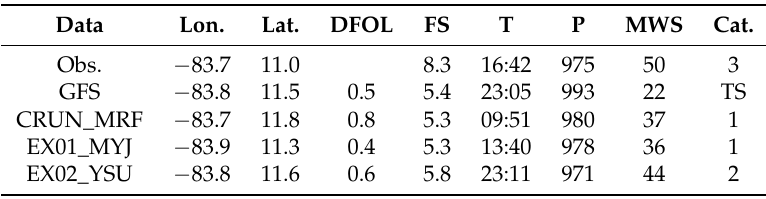
Table 2. Landfall measurements of Hurricane Otto from Best Track database and simulation using the WRF-ARW modelling system. Storm categories are taken from the Saffir-Simpson hurricane wind scale. GFS is the Global Forecasting System model. CRUN_MRF, EX01_MYJ, and EX02_YSU are: the control-run using the Medium Range Forecast, the Mellor-Yamada-Janjic and the Yonsei University schemes, respectively. The columns are DFOL: distance from observed landfall in degrees, FS: forward speed (m s − 1 ), T: Time (UTC), P: pressure (hPa), MWS: maximum wind speed (m s − 1 ) and Cat: Saffir-Simpson scale. Data Lon. Lat. DFOL FS T